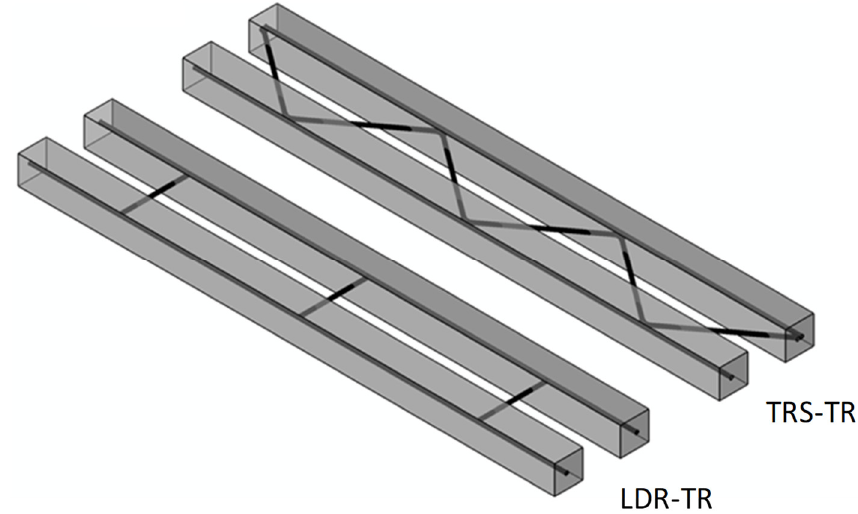
Figure 2. Two types of reinforced 3DPC wall sections.